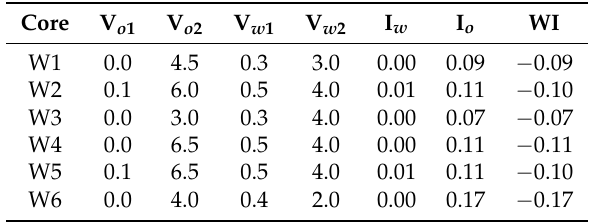
Table 4. Amott–Harvey wettability indexes measured on aged